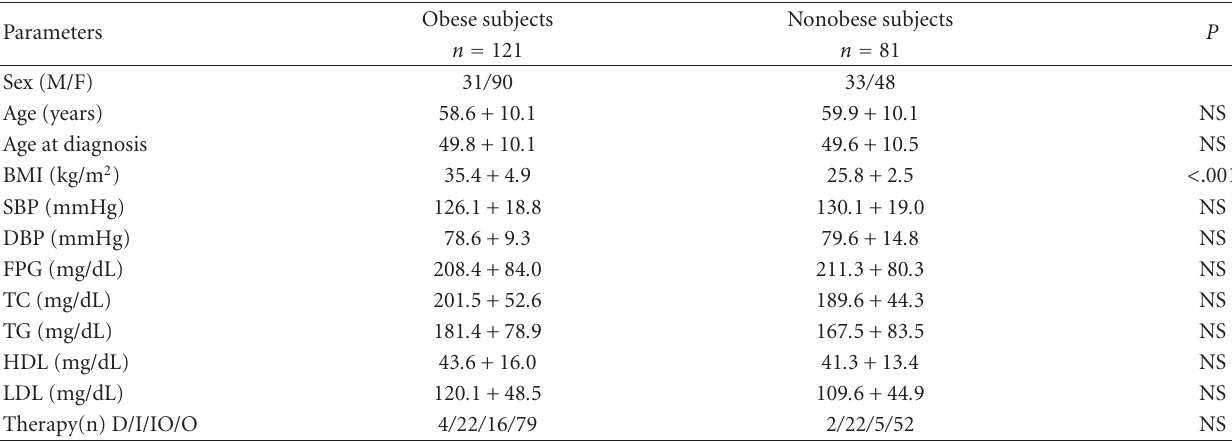
Table 1: Anthropometrical and biochemical parameters of the study groups. Data are in means ± SD. BMI = Body mass index; SBP = systolic blood pressure; DBP = diastolic blood pressure; TC: total cholesterol; TG: Triglyceride; FPG: fasting plasma glucose; NS: not significant; D: Diet; I: insulin; IO: Insulin and oral hypoglycemic agent; O: oral hypoglycemic